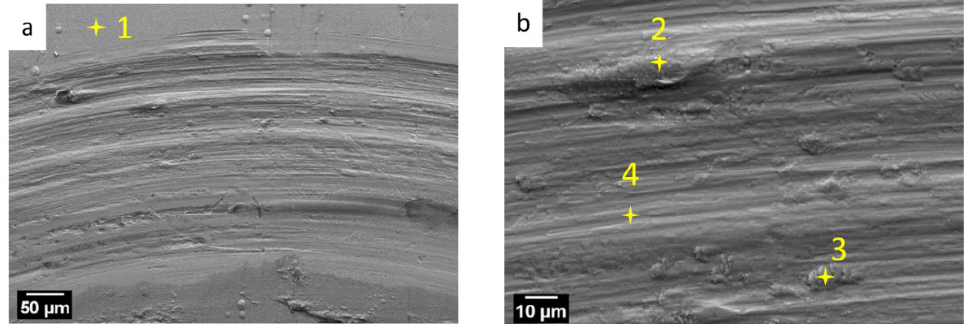
Figure 10. Scanning Electron Microscope micrographs of the wear track of the hard Cr coatings ( a ). The micrograph in ( b ) is acquired at higher magnification. The different representative areas where the EDS point analyses were performed are highlighted with the numbering 1 to 4, and the results are collected in Table 2.